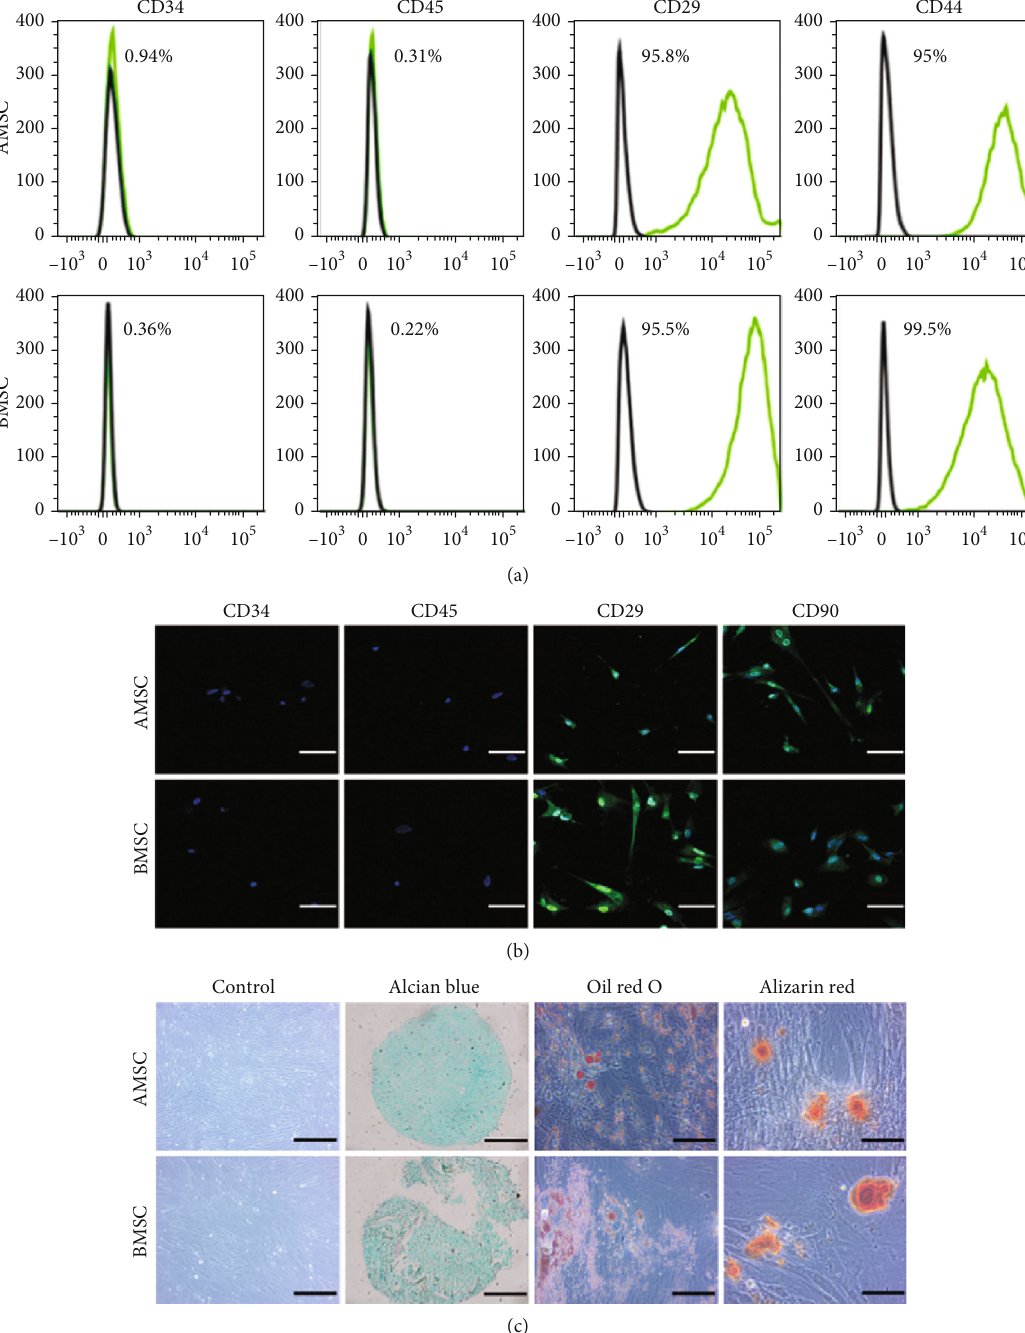
Figure 3: Identi fi cation of AMSCs and BMSCs. (a) Flow cytometric analysis of immunophenotypic pro fi les of AMSCs and BMSCs. (b) Laser scanning confocal microscopic images of immuno fl uorescence staining for MSC-speci fi c markers CD29 and CD90 and hematopoietic lineage markers CD34 and CD45. Scale bar = 50 μ m . Magni fi cation: × 400. (c) Light micrographs and trilineage di ff erentiation of AMSCs and BMSCs to chondrocytes stained with Alcian Blue, adipocytes stained with Oil Red O, and osteocytes stained with Alizarin Red. Control and Alcian Blue staining: scalebar = 200 μ m; magni fi cation: × 200. Oil Red O and Alizarin Red staining: scale bar = 100 μ m; magni fi cation: ×